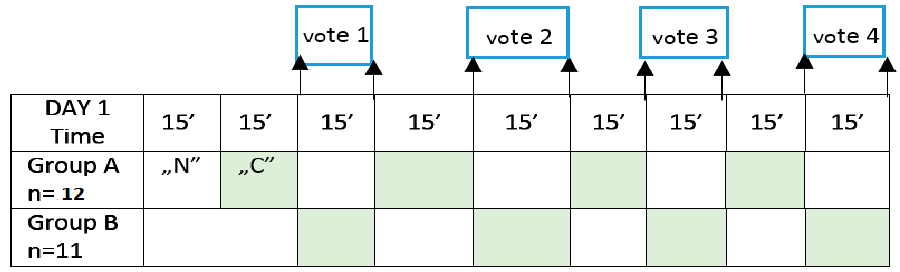
Figure 3. Experimental timetable (day 1, n = 23, “N”—neutral conditions, “C”—test chamber).